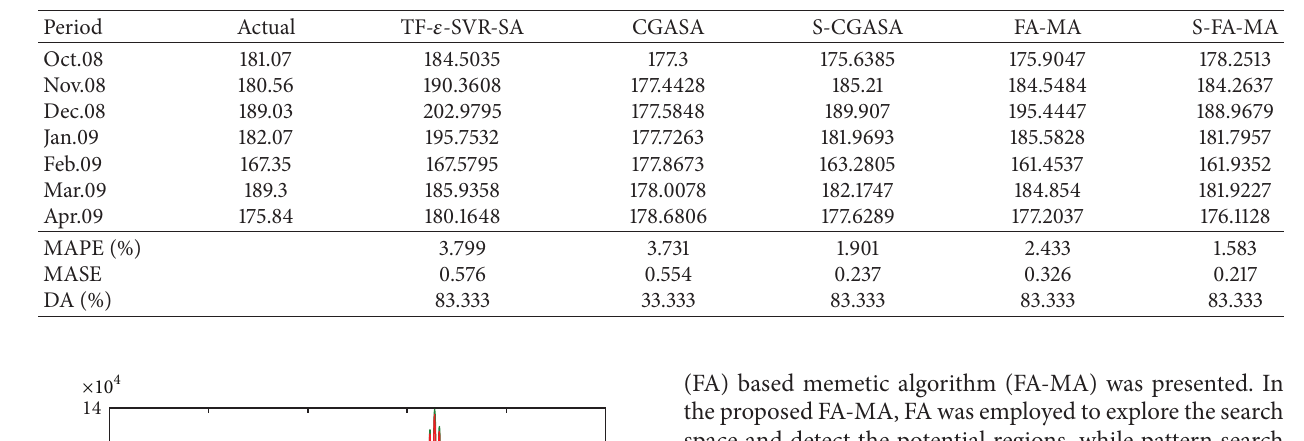
Table 10: Comparison with existing hybrid algorithms.